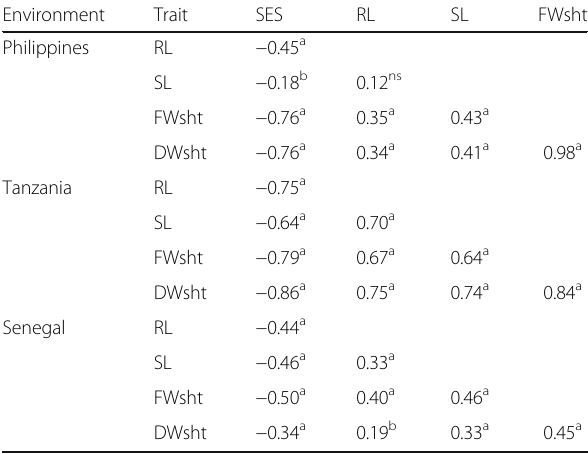
Table 1 Correlation coefficients among different traits in an F 5 (RIL) population of a cross between IR29 (salt sensitive) and Hasawi (salt tolerant) at seedling stage under three different environments